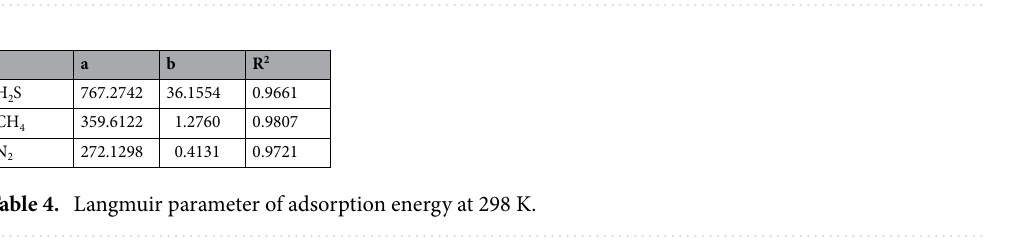
Figure 6. Adsorption energy of H 2 S, CH 4 and N 2 : variation with pressure.